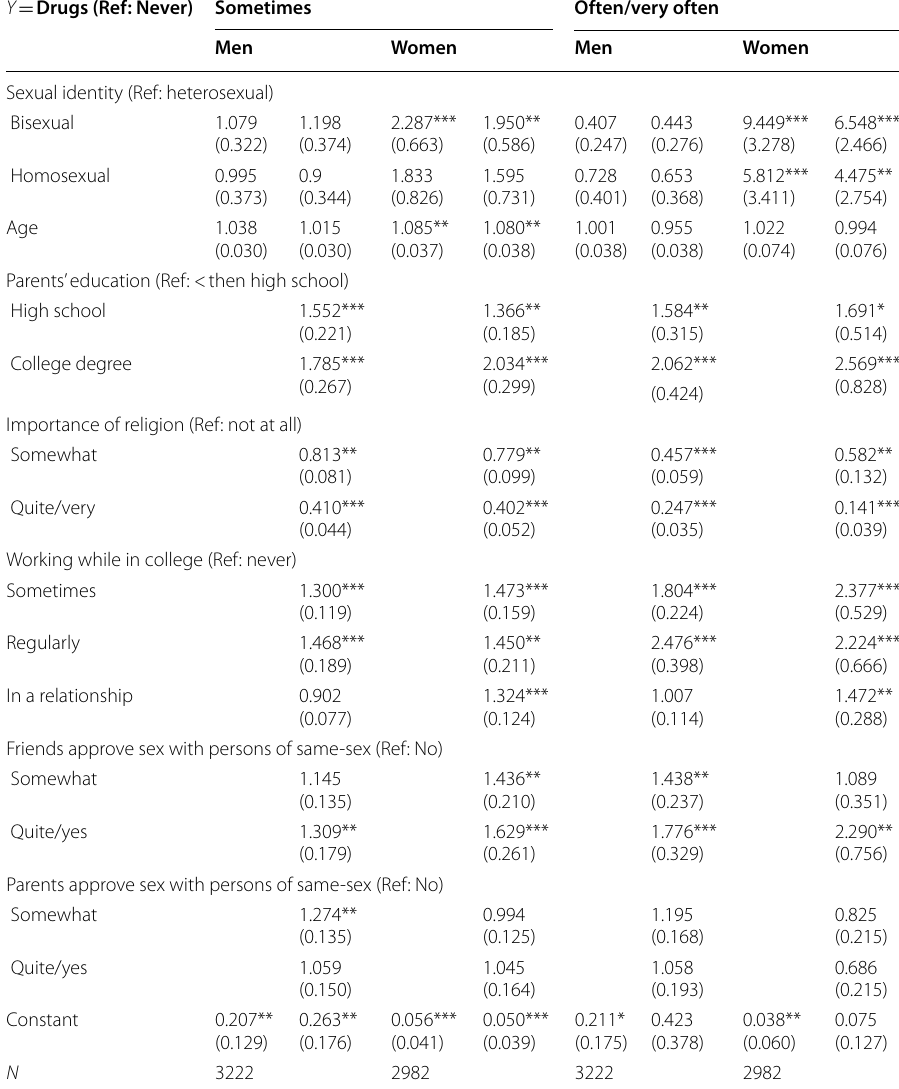
Table 4 Multinomial logistic regression, marijuana and/or ecstasy